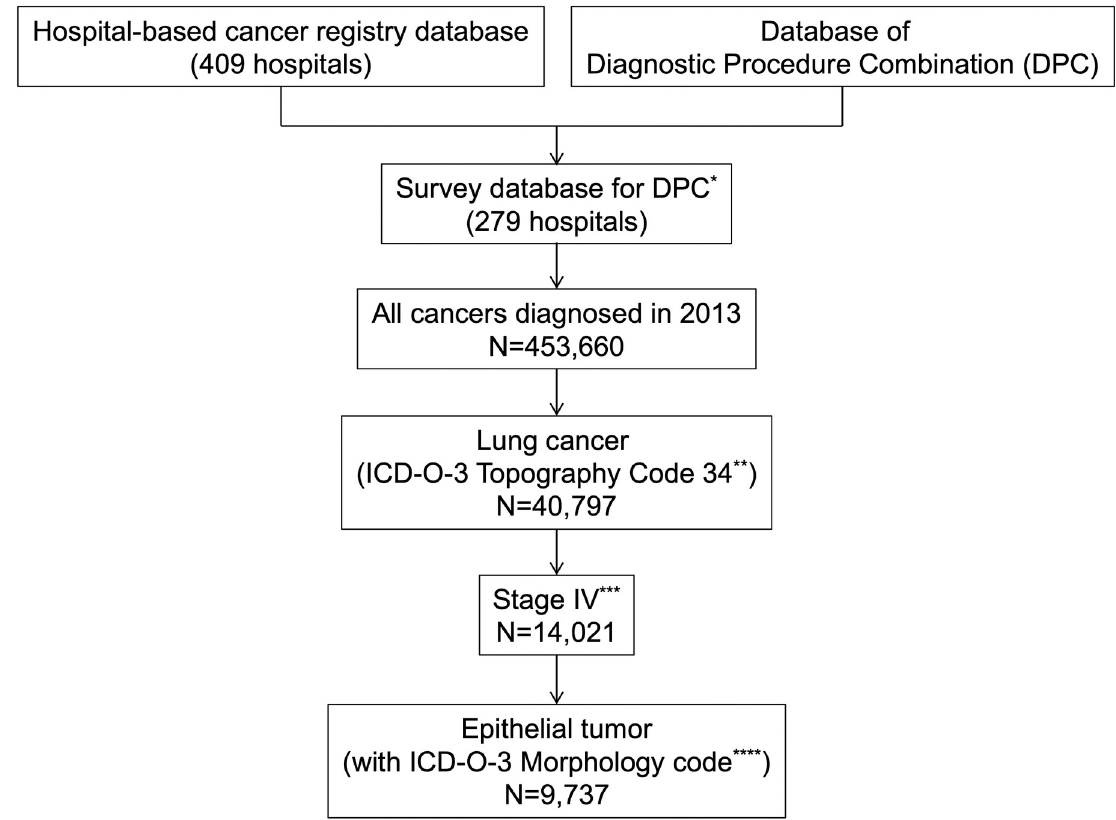
Fig 1. Flow chart for selection of the study population. The survey database for Diagnostic Procedure Combination (DPC) was combined with the hospital-based cancer registry and the DPC. � Patients who had a diagnosis and a selected first choice of treatment including best supportive care, were included in the survey database. �� ICD-O-3 topography codes C34.0 (main bronchus), C34.1 (upper lobe of lung), C34.2 (middle lobe of lung), C34.3 (lower lobe of lung), C34.8 (overlapping lesion of lung), C34.9 (lung, not otherwise specified) were identified. ��� Patients with de novo stage IV disease as per the UICC classification were identified. ���� Adenocarcinomas (ICD-O-3 morphology codes 8140, 8250, 8551, 8260, 8265, 8230, 8253, 8254, 8480, 8333, and 8144), squamous cell carcinomas (8070, 8071, 8072, and 8083), neuroendocrine carcinomas (8041, 8045, and 8013), carcinoid tumors (8240, 8249, 8012, and 8560), sarcomatoid carcinomas (8022, 8032, 8031, 8980, and 8972), other and unclassified carcinomas (8082 and 8023), and salivary gland-type tumors (8430, 8200, and 8562) were